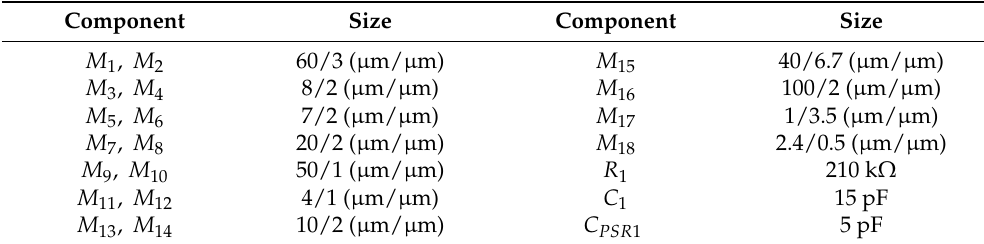
Figure 6. Operational Amplifier Circuit Topology. Table 2. Sizes of the Components in Operational